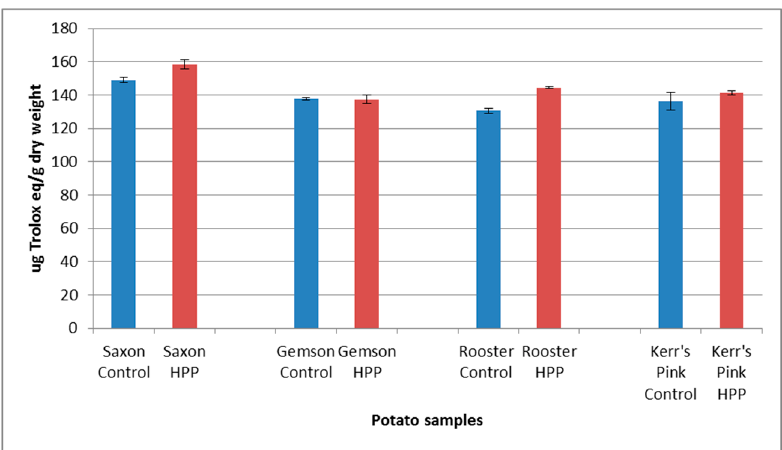
Figure 1. Effect of HPP treatment on antioxidant activity of potatoes as measured by FRAP assay and expressed as µg of Trolox equivalents per g of potato dry weight. Values presented are the average ± SD.